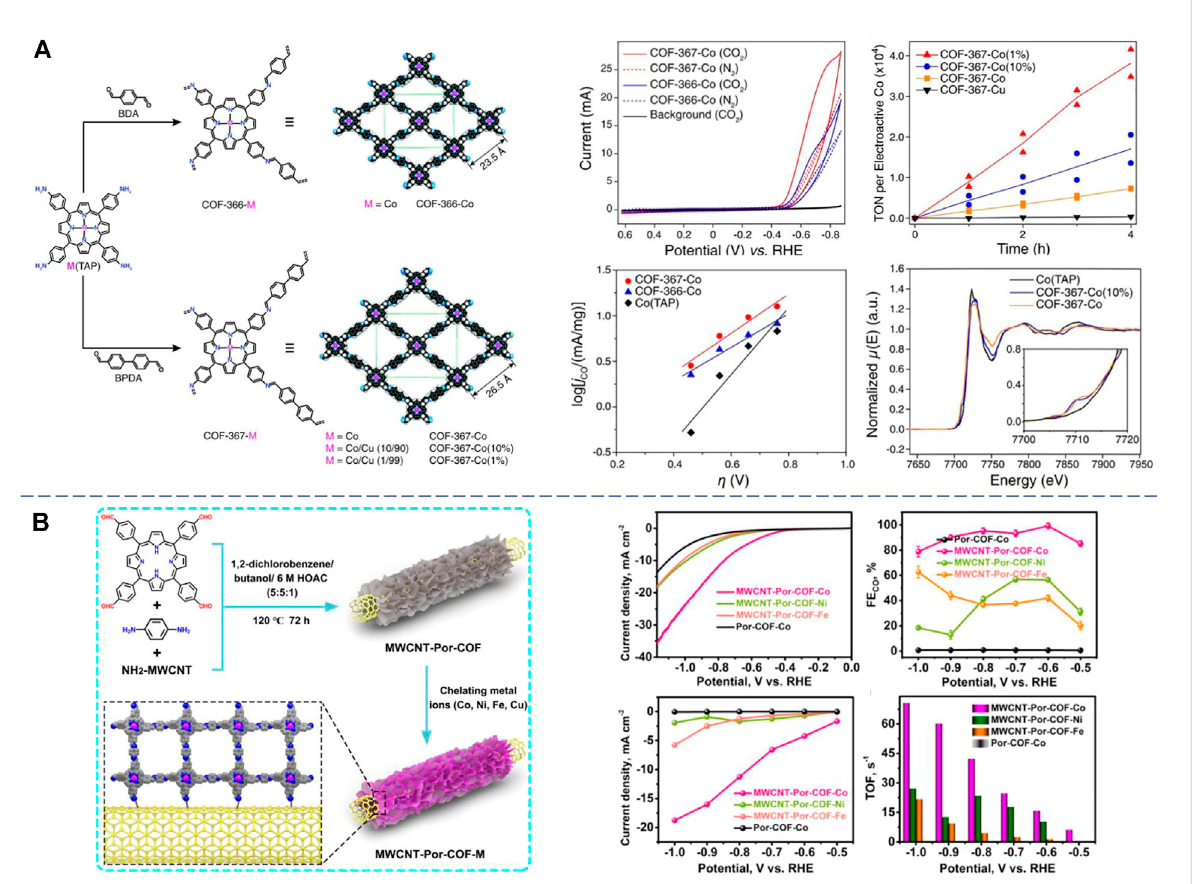
FIGURE 1 (A) Structures, electrochemical characterizations, and carbon dioxide reduction performance of the metalloporphyrin-derived 2D covalent organic frameworks COF-366-Co and COF-367-Co [reproduced from Lin et al. (2015) with the permission of AAAS]. (B) Design and synthesis of MWCNT-Por-COF-M and its electrochemical characterizations and carbon dioxide reduction performance [reproduced from Dong et al. (2022) with the permission of